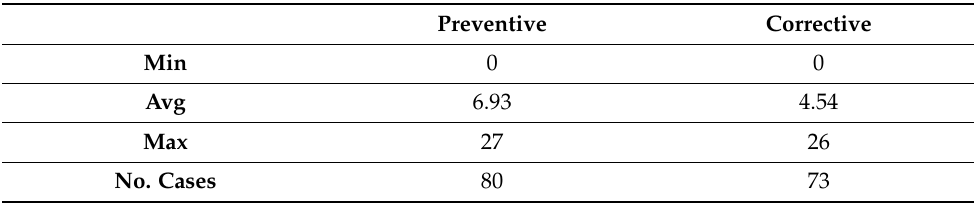
Table 7. N-1 security criteria violations for the optimal solutions of N70